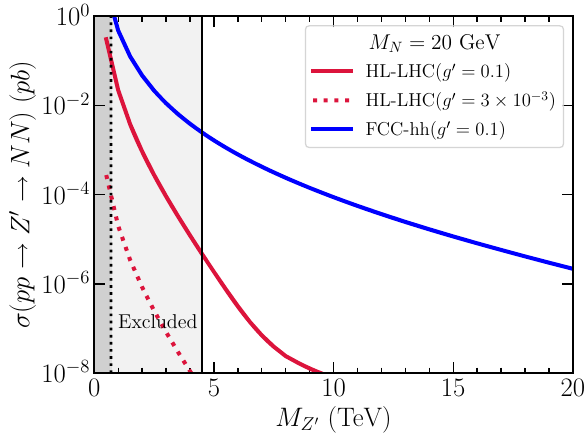
Fig. 3 Cross-section σ( pp → Z (cid:2) → N N ) as a function of M Z (cid:2) at the HL-LHC and FCC-hh, for M N = 20 GeV. The black solid (dashed) line represents LHC limits for g (cid:2) = 0 . 1 ( 3 × 10 − 3 ) as shown in Fig.